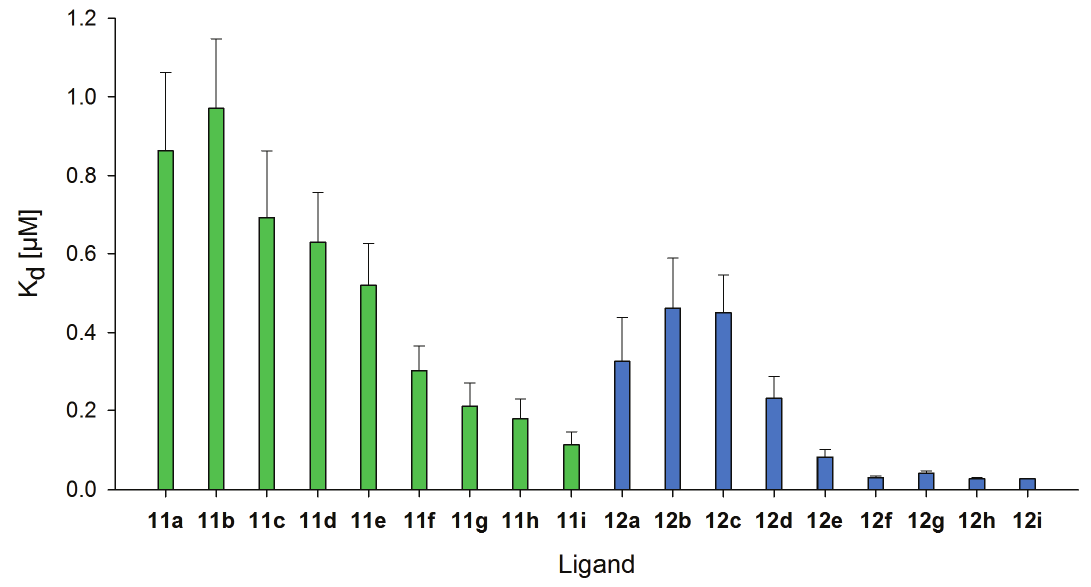
Figure 4. K d values of human galectin-3 binding to different neo-glycoproteins. The K d values enable the comparison of the affinity of galectin-3 to the tested neo-glycoproteins modified with LacNAc-LacNAc 11a – i ((cid:4)) and LacDiNAc-LacNAc 12a – i ((cid:4)). K d values in [μM] were calculated using Sigma Plot